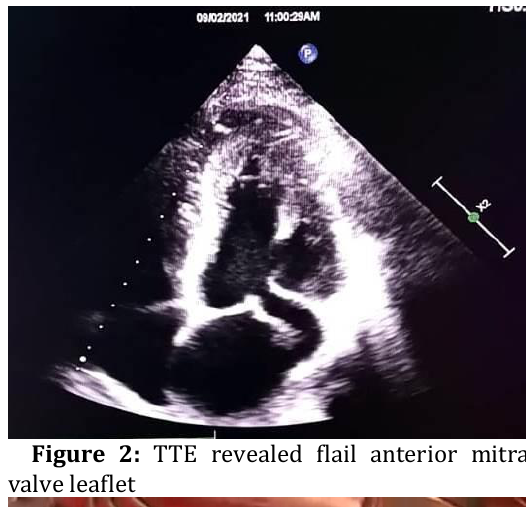
Figure 2: TTE revealed flail anterior mitral valve leaflet